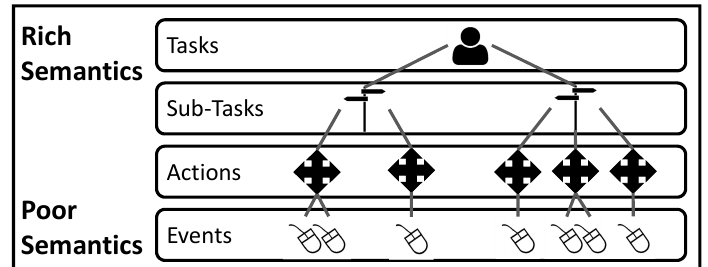
Figure 2: An illustration of the hierarchical model of user analytical behavior by Gotz and Zhou